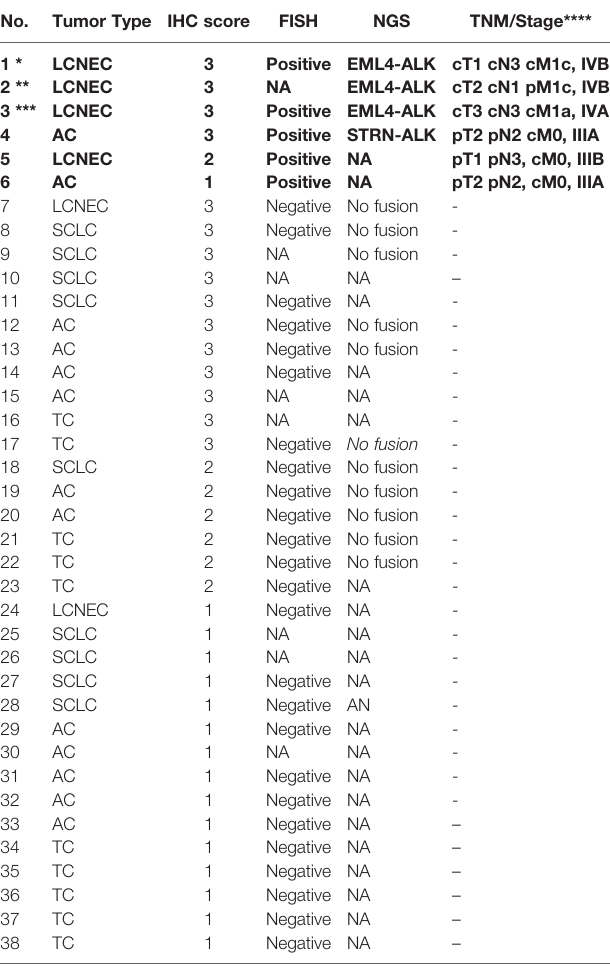
TABLE 2 | Clinicopathological data and ALK results for all ALK IHC-positive (1+ to 3+) cases. No. Tumor Type IHC